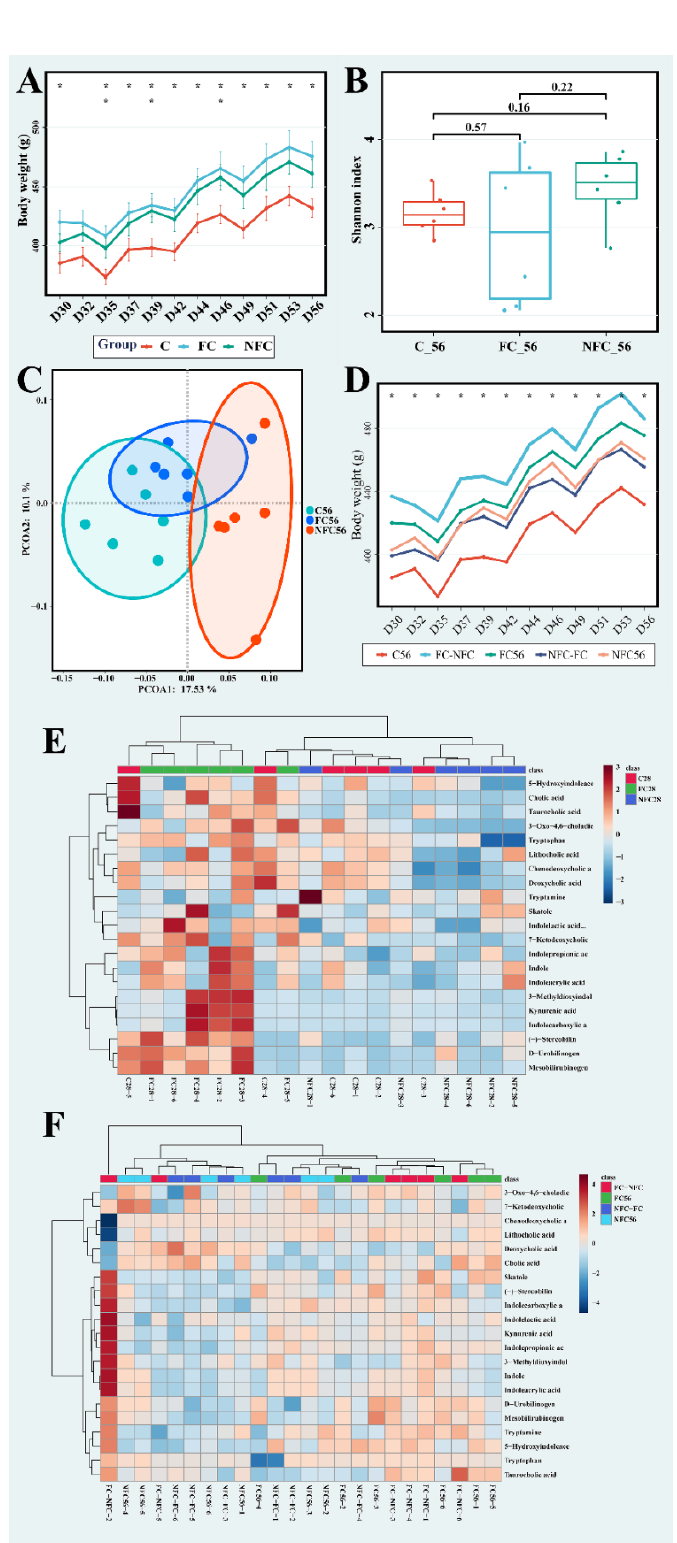
Figure 4. The effect of NFC and FC CAJ in rats in the prolonged and juice-switch period: ( A ) Body weight in prolonged period; * ( p < 0.05) and ** ( p < 0.01) in the first/second indicates significant difference between FC56/NFC56 and C56 groups. ( B ) Shannon index. ( C ) PCoA scores plot on OTU level. ( D ) Body weight in juice-switch period; * indicates the significant difference ( p < 0.05) between FC-NFC and C56 groups. ( E , F ) Heatmaps from hierarchical clustering analysis for differential metabolites on D28 and D56.